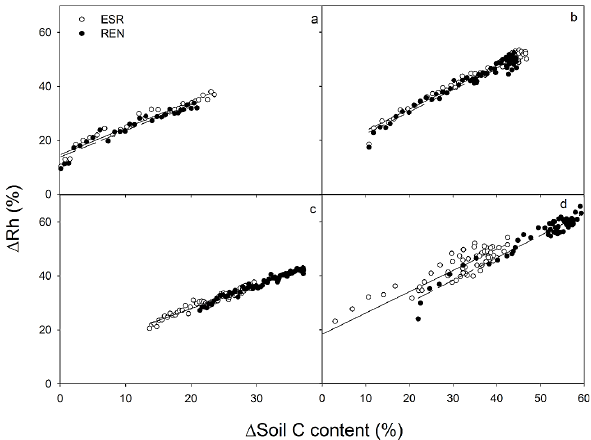
Fig. 6. Relationships between drought-induced relative reduction in soil C content and relative reduction in R h in four North American grasslands (Konza: a ; Hays: b ; Cheyenne: c ; Sevilleta: d ). Open circles represent ESR treatment. Solid circles represent REN treat- ment. Drought-induced reductions in soil C were significantly and positively related to R h